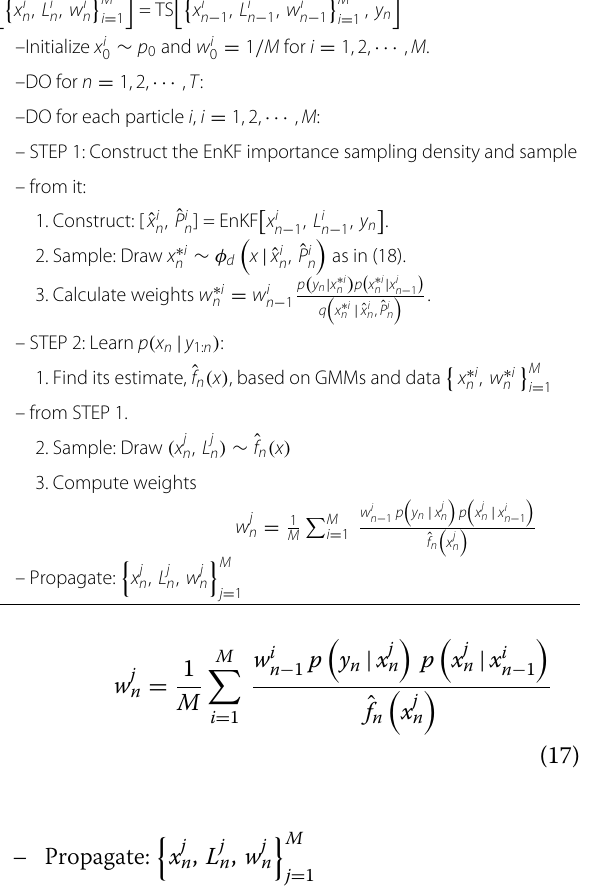
Table 3 Two-step particle filtering (TS) algorithm (cid:9)(cid:3) (cid:4) M x i n , L i n , w i n i =